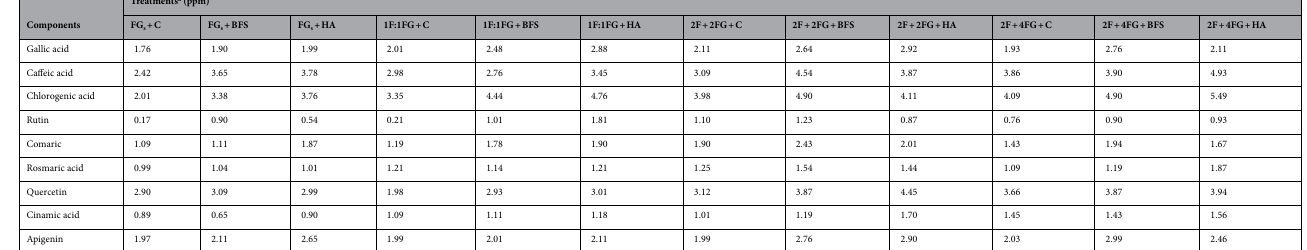
Table 8. Proportion of fenugreek concentration of phenolic compounds under different cropping patterns and fertilization. a C (control), BFS (biofertilizers), HA (humic acid), and FGs (fenugreek sole cropping), 1F:2FG, 2F:2FG, and 2F:4FG are the ratios of fennel and fenugreek in the intercropping